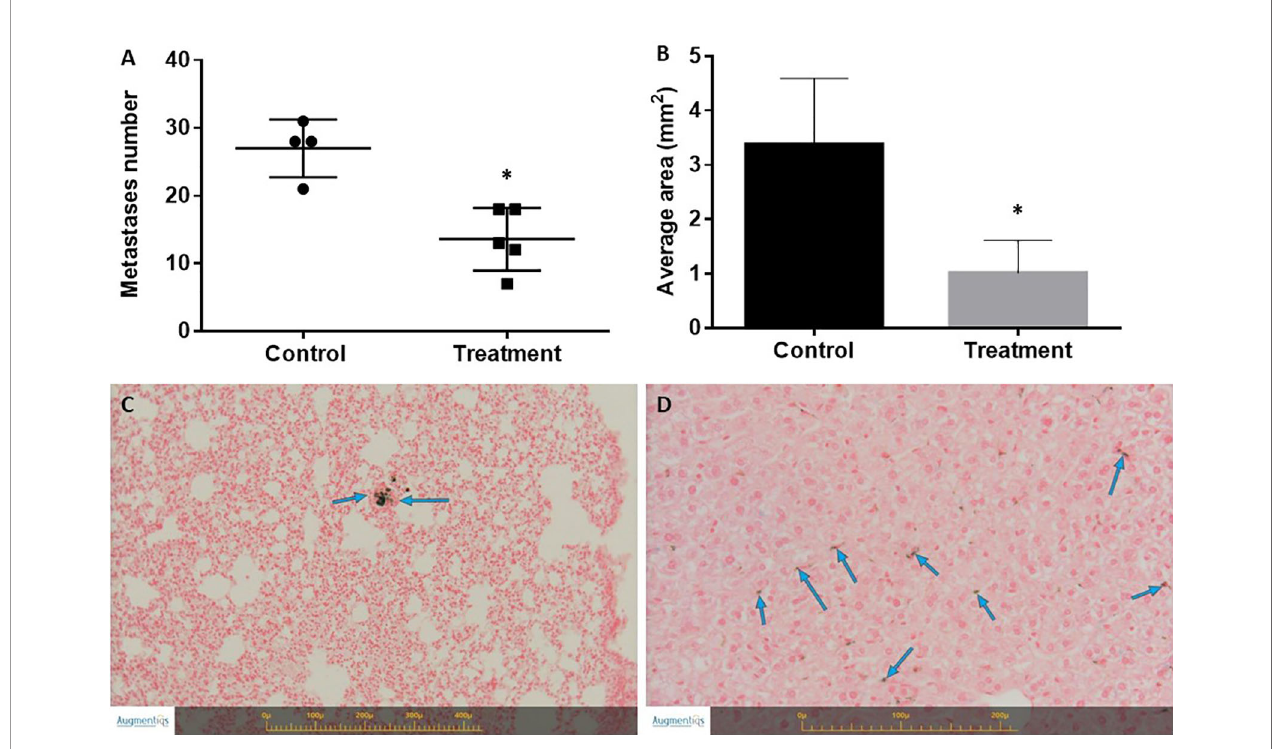
FIGURE 6 | Effect of treatment on the number of lung metastases and tumor size in the 4T1 breast cancer model. (A) Number of lung metastases. Mice were sacri fi ced on day 17 following cancer model induction. The lungs were excised and the number of metastases was counted. *Statistically signi fi cant difference. (B) Tumor size determined by histopathology and 2-D morphometric analysis expressed as average tumor area (mm 2 ). *Statistically signi fi cant difference. (C) Representative section of Prussian blue staining of the lungs of treated mice. Blue arrows indicate Prussian blue positive pigment laden macrophages. No in fl ammation was associated with the presence of pigment. (D) Representative section of Prussian blue staining of the liver of treated mice. Blue arrows indicate Prussian blue positive pigment laden macrophages (Kupffer cells). No in fl ammation was associated with the presence of pigment. Images were captured using the Augmentiqs system software (14).